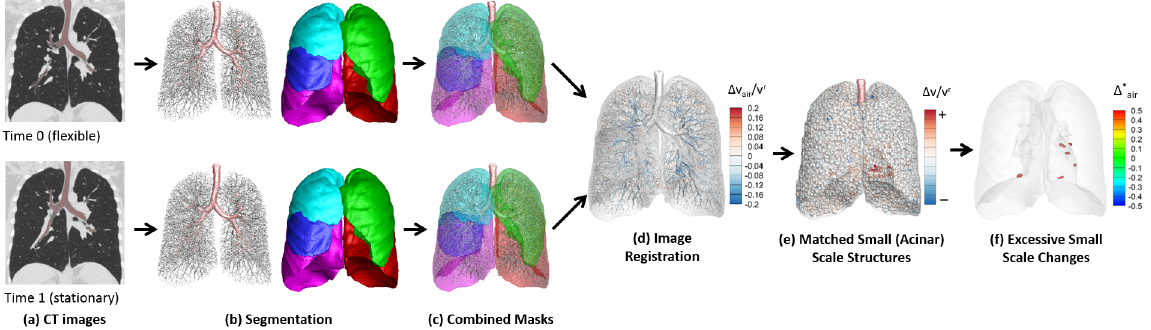
Fig 1. Schematic of flow chart to assessregional lung mechanics based on a pair of serial CT scans.